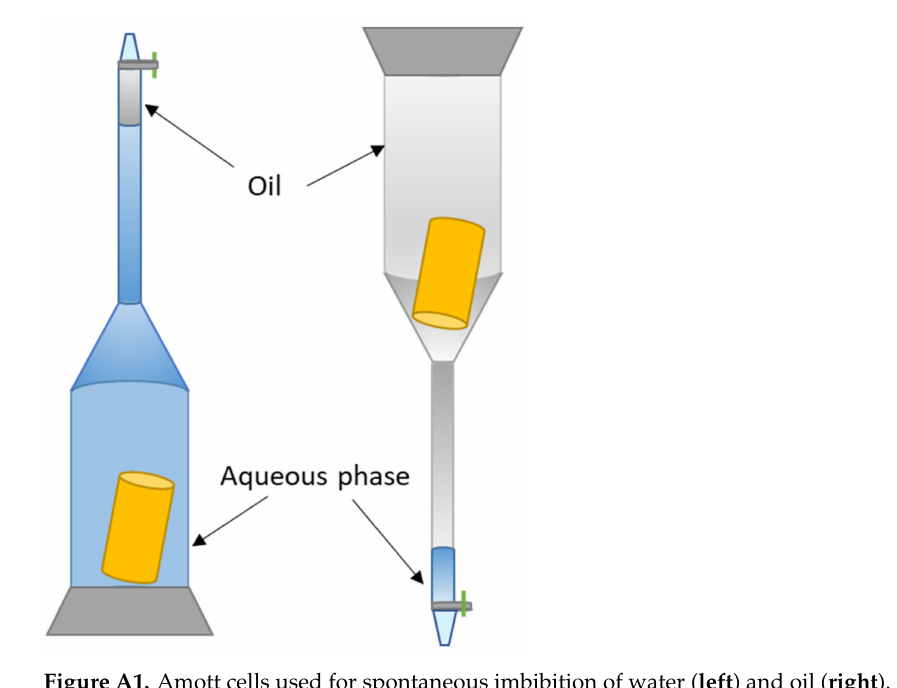
Figure A1. Amott cells used for spontaneous imbibition of water ( left ) and oil ( right ). Spontaneous imbibition was performed at ambient conditions.